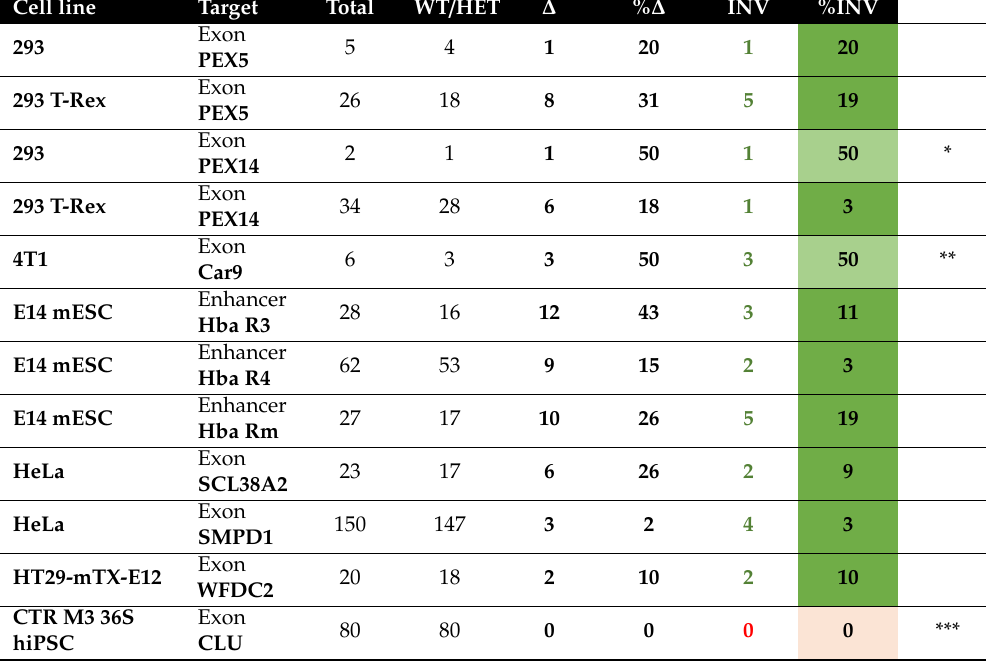
Table 1. Screening cell lines for targeted